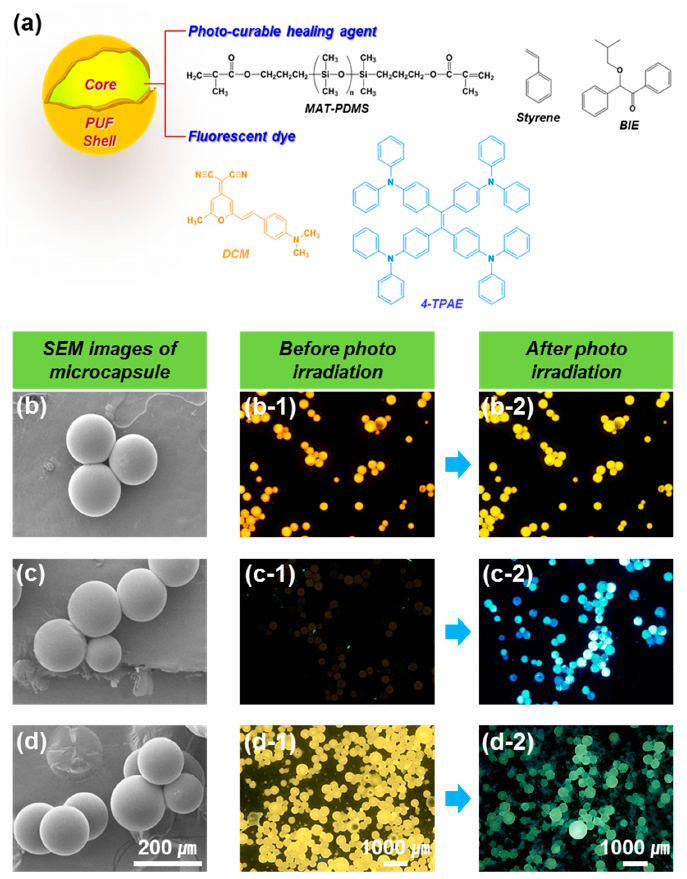
Figure 4. ( a ) Dye-loaded microcapsules and chemical structure of healing agents and fluorescence dyes, SEM, and optical microscope images (under 330 ~ 385 nm UV source) of microcapsules